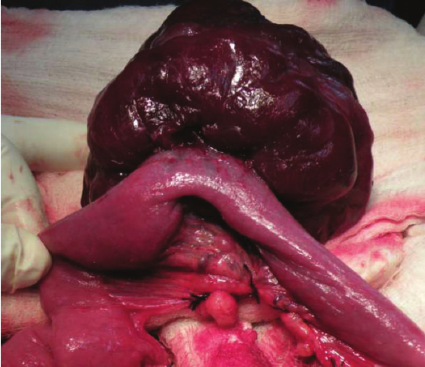
Figure 3: Well vascularised mass adherent to the bowel wall.